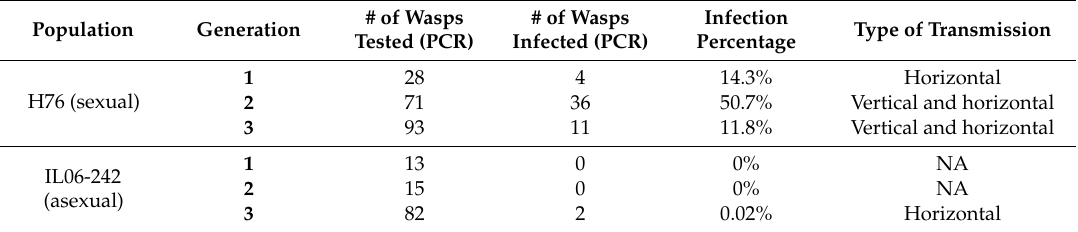
Table 3. Infection percentages of wasp lines used for the setup of the transmission assay. Only H76 wasps were already virally infected at generation 1.